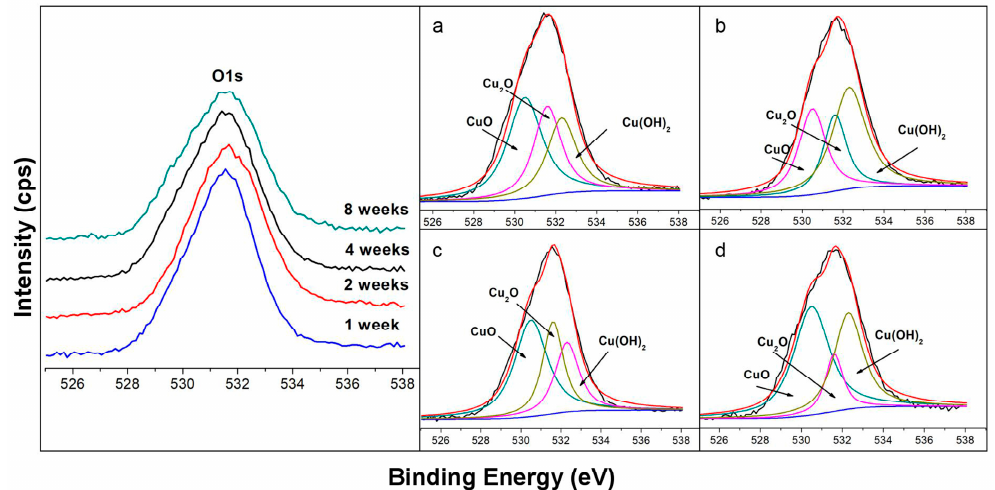
Figure 2. O XPS spectra of the corrosion product layer on the surface of the 90/10 Cu-Ni alloy in the natural seawater for different days: ( a ) Core-level O1s spectrum for 7 days; ( b ) core-level O1s spectrum for 14 days; ( c ) core-level O1s spectrum for 28 days; ( d ) core-level O1s spectrum for 56 days. Table 3. Fitting parameters for O1s XPS spectra and relative quantity of compounds in the corrosion layers of 90 / 10 Cu-Ni alloy exposed to seawater for di ff erent days.